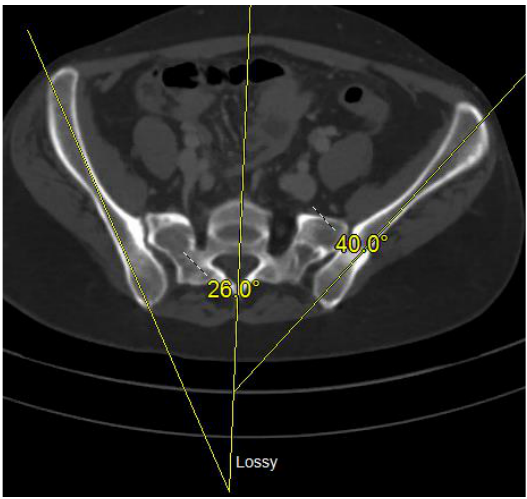
Figure 2. Axial CT image of a pelvic malunion with internal rotation deformity of the right hemi- pelvis.